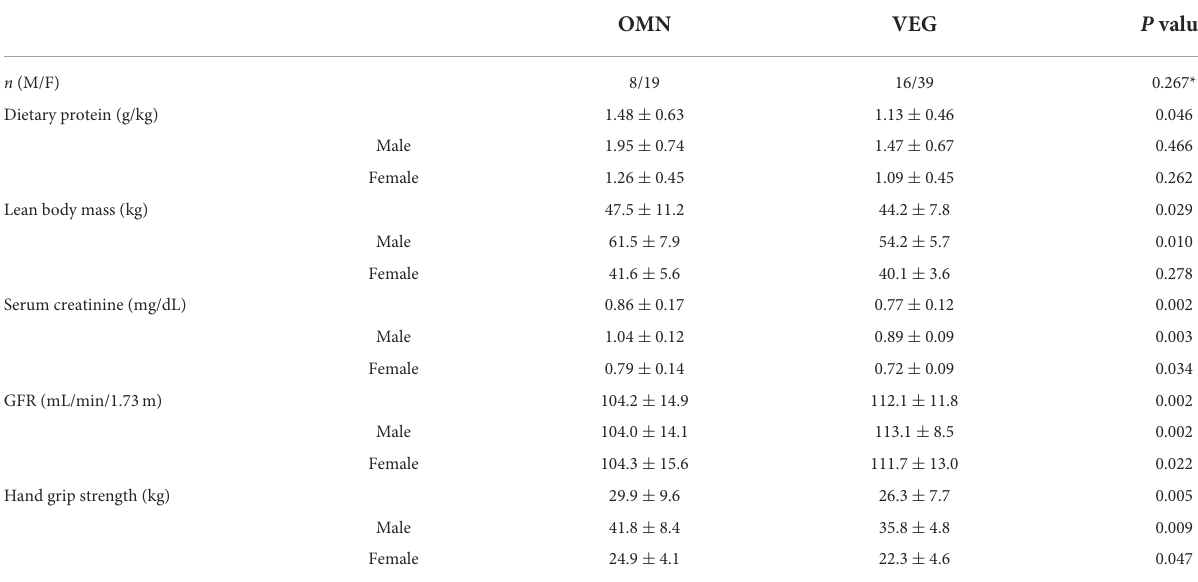
OMN VEG P value